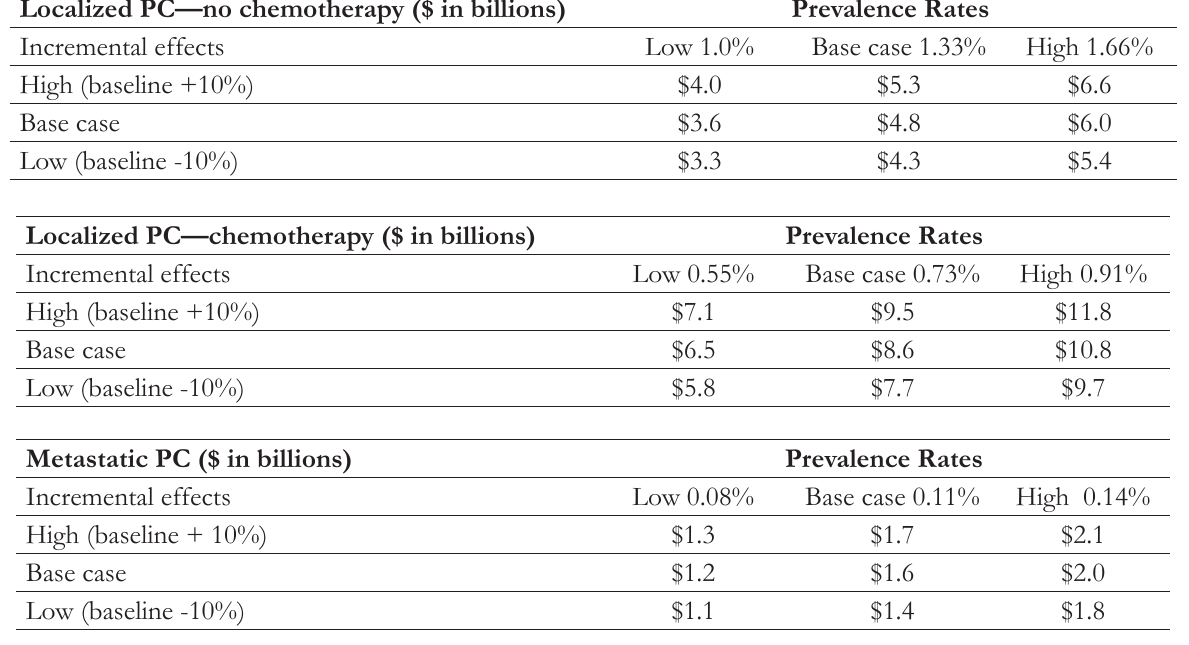
Table 6. Aggregate Expenditures and Sensitivity Analyses [$ billions per annum, 2011 dollars] Localized PC—no chemotherapy ($ in